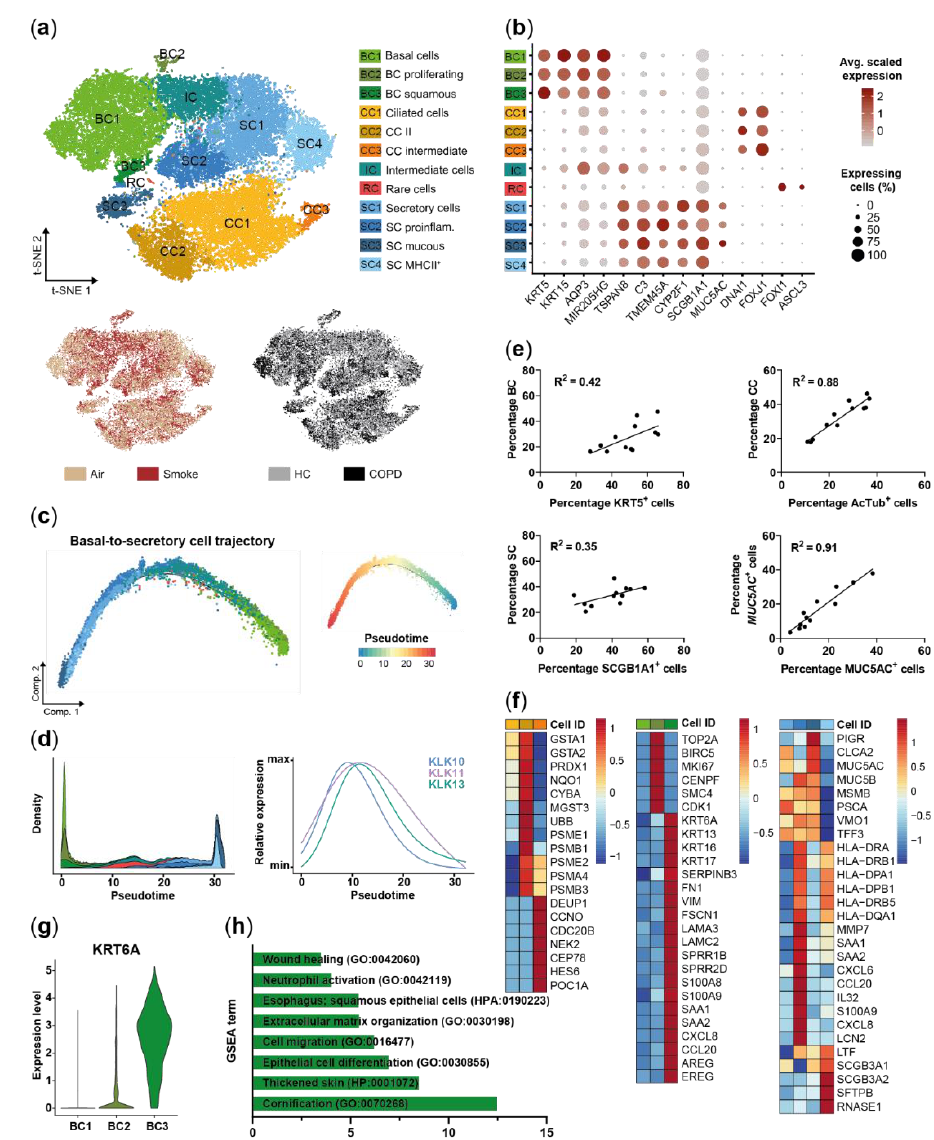
Figure 2. Characterization of the small airway epithelial cell population. ( a ) T-SNE plot illustrating the 12 clusters identified in the integrated scRNA-seq data sets of all donors ( n = 3 healthy controls (HC) and COPD patients, respectively) including three basal cell (BC) clusters, three ciliated cell (CC) clusters, a basal/secretory intermediate cell (IC) cluster, a rare cell (RC) cluster and four secretory cell (SC) clusters. T-SNE plots in the lower panel illustrate cells by smoking and disease status. ( b ) Relative expression and fraction of cells that express BC ( KRT5 , KRT15 ), CC ( FOXJ1 , DNAI1 ), SC ( CYP2F1 , SCGB1A1 ) and RC ( FOXI1 , ASCL3 ) marker genes across the cell clusters. Low expression levels of typical BC and SC markers are detected in IC, however, IC express a set of genes that are strongly expressed in BC or SC ( AQP3 , MIR205HG , TSPAN8 , C3 ). ( c ) Pseudotime analysis of SAEC populations ( n = 6, air control and smoke-exposed samples of HC) focused on BC/IC/SC relationship. Trajectories show annotated cell IDs (left) using the color code from ( a ) and pseudotime values (right) per cell. ( d ) Left panel represents density (stacked) of the SAEC populations along pseudotime. The right panel depicts the modelled, relative expression of selected kallikrein-related peptidase encoding genes along pseudotime. ( e ) Correlation of relative cell type frequencies (HC and COPD donors) as determined by scRNA-seq (y-axis) and established protein markers of the respective cell types using flow cytometry (x-axis). ( f ) Heatmaps depict relative expression levels of selected genes that are significantly differentially expressed (adj. p < 0.05, abs. fold change ≥ 1.5) across CC, BC and SC subpopulations. ( g ) Normalized KRT6A expression levels in cells of the three BC subpopulations. ( h ) Selected molecular processes that are significantly (adj. p < 0.05) associated with BC3 as determined by gene set enrichment analysis (GSEA) of the genes significantly increased compared to BC1 and BC2. AcTub: acetylated-tubulin.